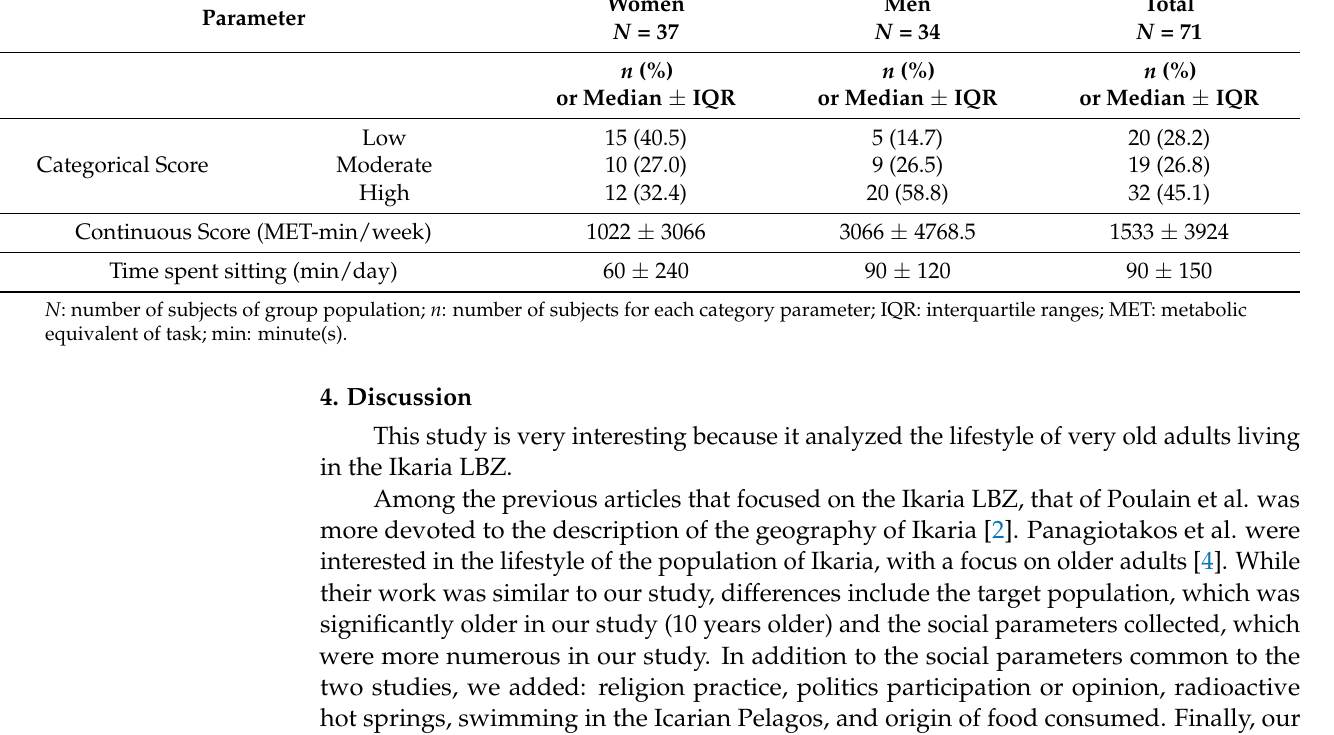
Table 3. Results of the physical activity assessment using the international physical activity questionnaire (IPAQ).